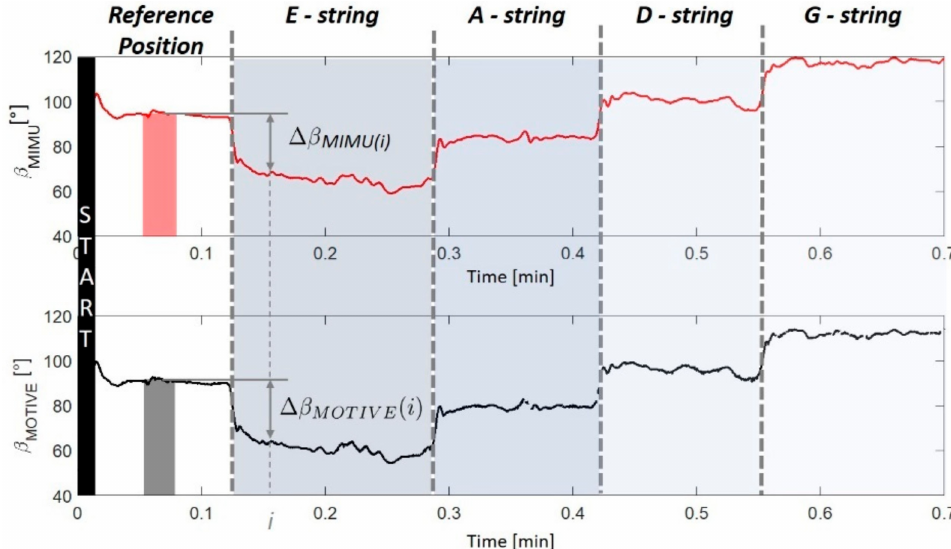
Figure 5. Example of computation of angular displacement ∆ β with respect to the reference